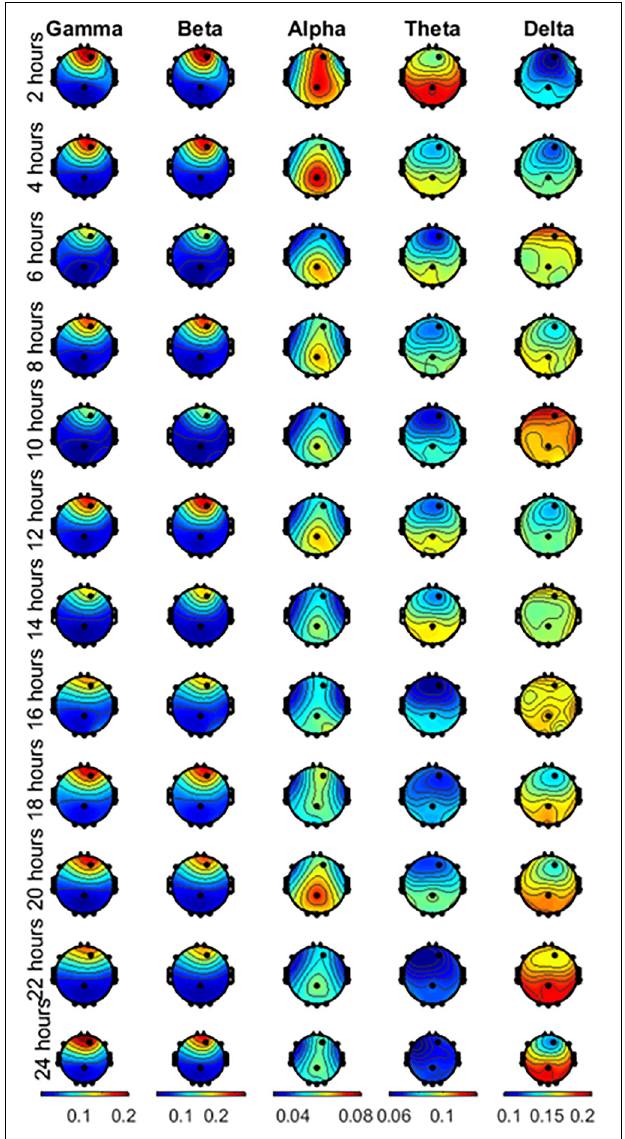
FIGURE 3 | Averaged scalp topographies of the gamma, beta, alpha, theta and delta waves of the subjects performing the EAT for the 12 runs during the 24 h of